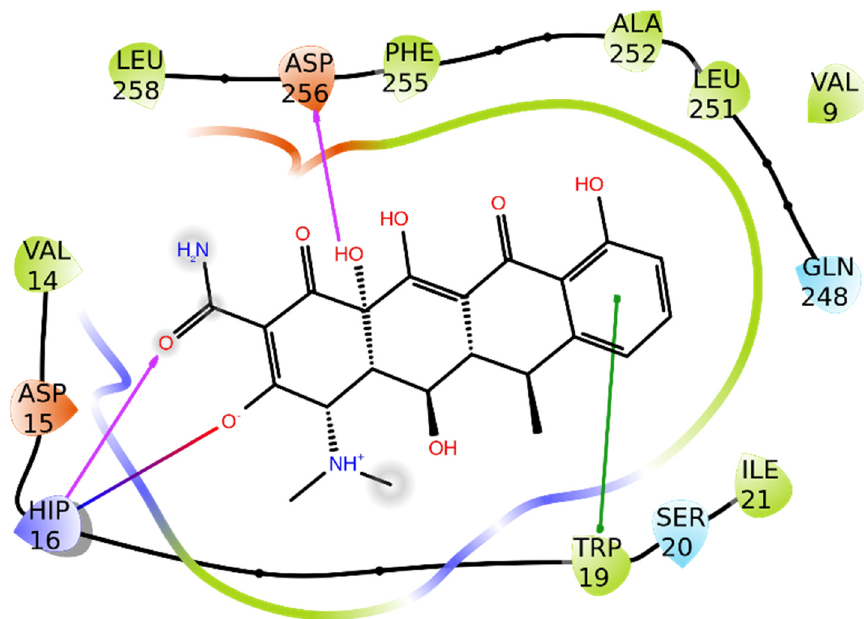
Figure 2. Binding mode of doxycycline with alpha-1-antichymotrypsin (5OM2) [41]. Pink arrows are hydrogen bonds, the green line represents a π – π interaction, and the red-to-blue line represents an ionic bridge. Green residues are hydrophobic ones, cyan indicates polar residues, and red or blue ones are negatively and positively charged, respectively.